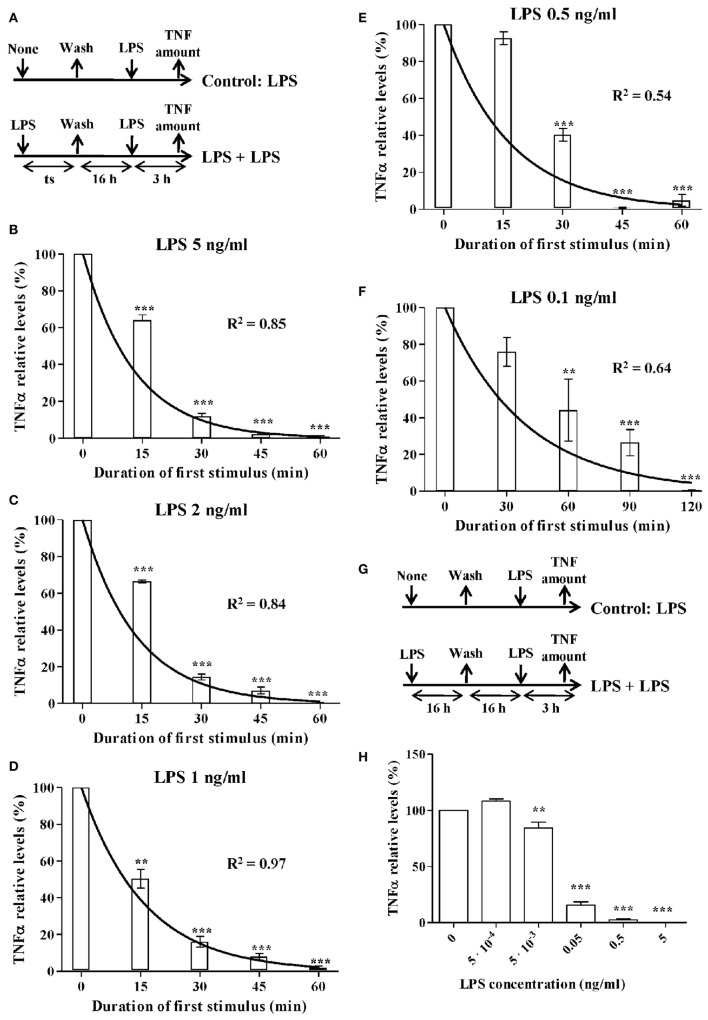
The activation rate of monocytes treated with lipopolysaccharides (LPSs). (A) Schematic representation of the endotoxin tolerance (ET) model used. Human monocytes isolated from PMBCs were pretreated with (B) 5 ng/ml, (C) 2 ng/ml, (D) 1 ng/ml, (E) 0.5 ng/ml, or (F) 0.1 ng/ml LPS for the indicated times (time of stimulation, ts), washed twice with PBS, cultured in medium for 16 h, and restimulated with 5 ng/ml LPS for 3 h. The supernatants were then harvested and the tumor necrosis factor alpha (TNFα) levels were evaluated by cytometric bead array (CBA). Relative TNFα levels to control monocytes without LPS pretreatment (treated only with the second LPS stimulus at 5 ng/ml), were expressed as mean ± SEM (n = 3 healthy volunteers). **p < 0.01; ***p < 0.001 compared with the value for the control as assessed by ANOVA and Dunnett’s Multiple Comparison post-test. Curves fitting the experimental data were obtained by non-linear regression. The coefficient of determination R2 is presented in each case to measure the goodness of the adjustment. (G) Schematic representation of the ET model used for low-LPS doses. (H) Human monocytes isolated from PMBCs were pretreated with the indicated LPS concentrations for 16 h, washed twice with PBS, cultured in medium for 16 h, and restimulated with 5 ng/ml LPS for 3 h. The supernatants were then harvested and the TNFα levels were evaluated by CBA. Relative TNFα levels to control monocytes without LPS pretreatment (treated only with the second LPS stimulus at 5 ng/ml), were expressed as mean ± SEM (n = 3 healthy volunteers). **p < 0.01; ***p < 0.001 compared with the value for the control as assessed by ANOVA and Dunnett’s Multiple Comparison post-test.